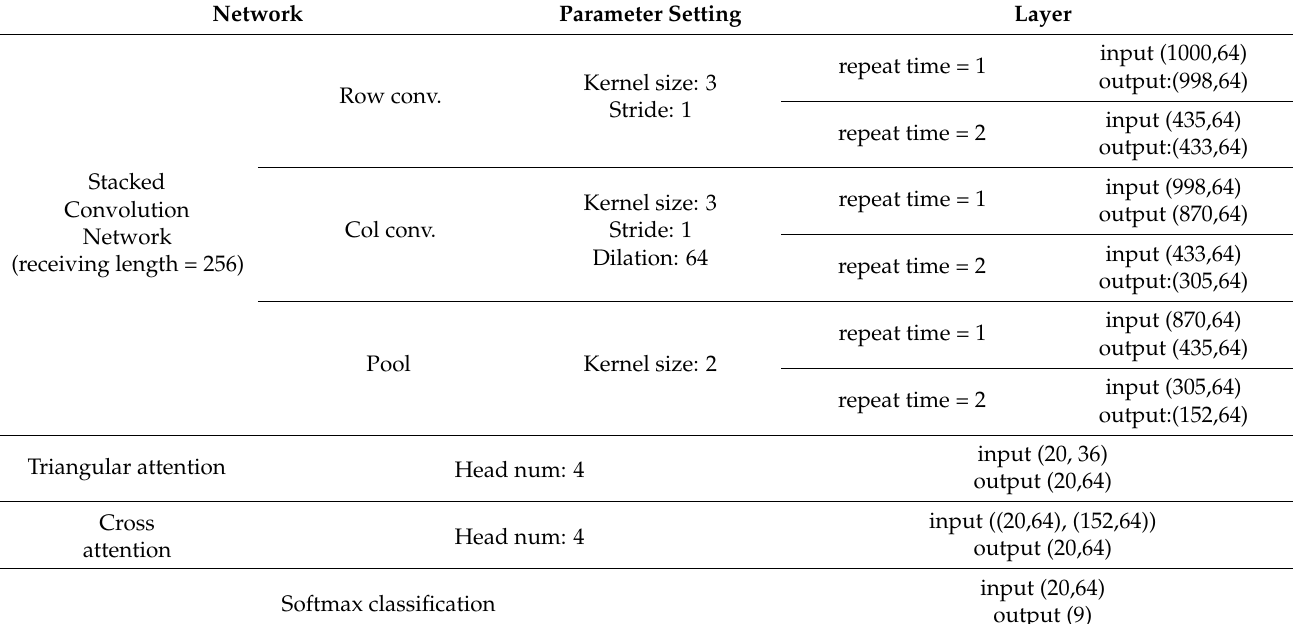
Table 3. The dimension change of each module on the detection model.